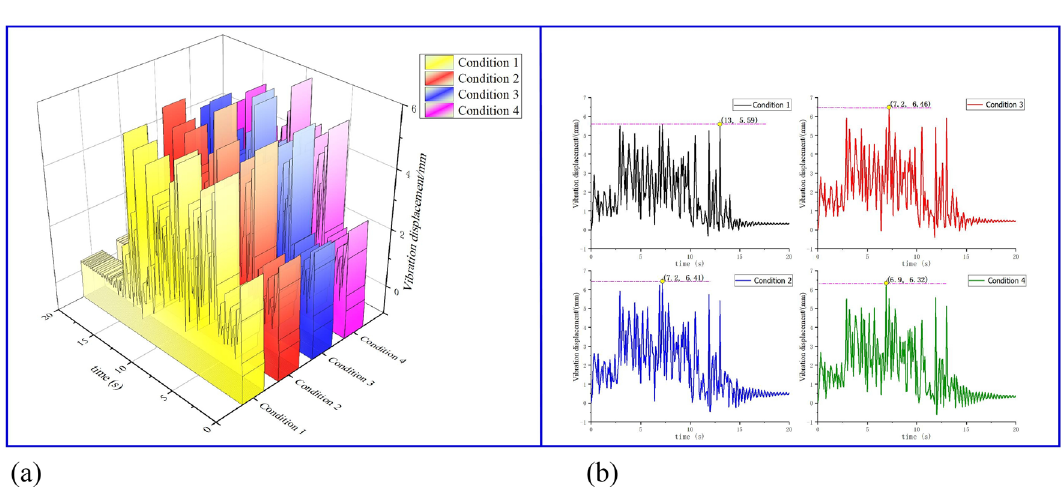
Figure 12. Vibration displacement diagram of drill pipe under multi-driller combination drilling: ( a ) curved surface of vibration displacement of drill pipe in multi drill combination drilling; ( b ) projection of vibration displacement of drill pipe in multi rig combination